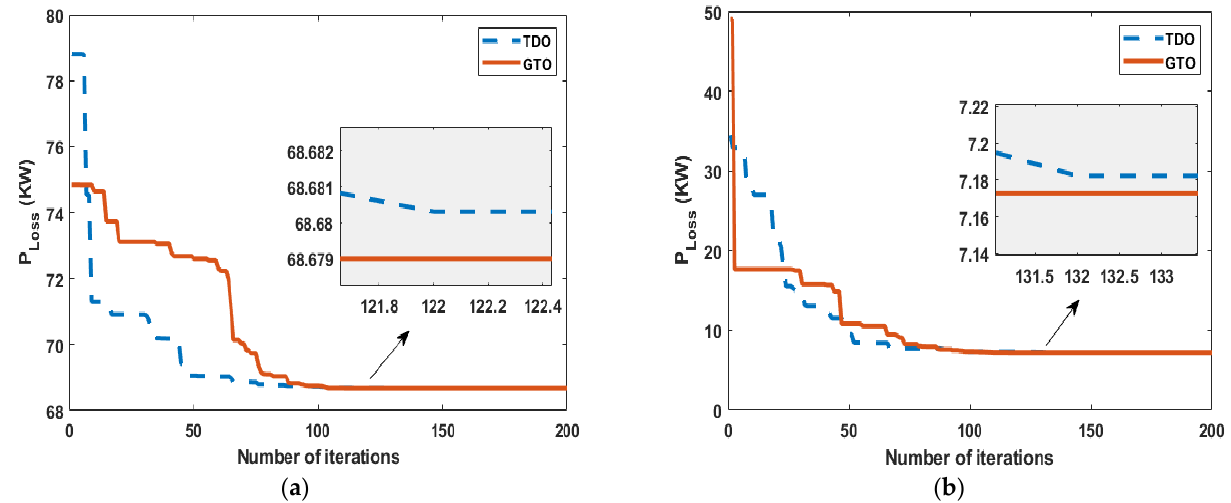
Figure 10. Convergence characteristics of the TDO and GTO algorithms for an IEEE 69-bus system